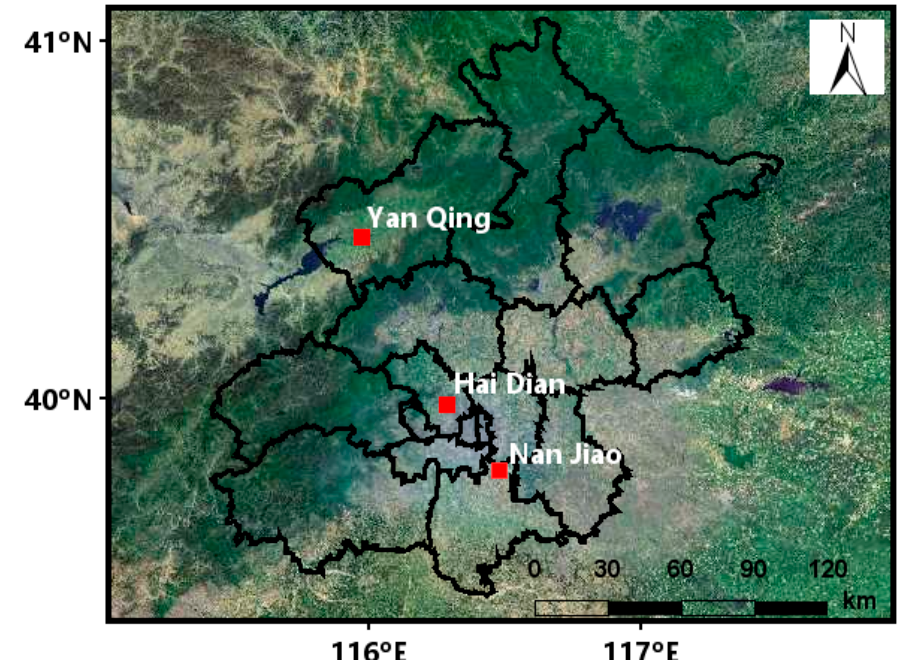
Figure 1. Location of Beijing lidar sites.